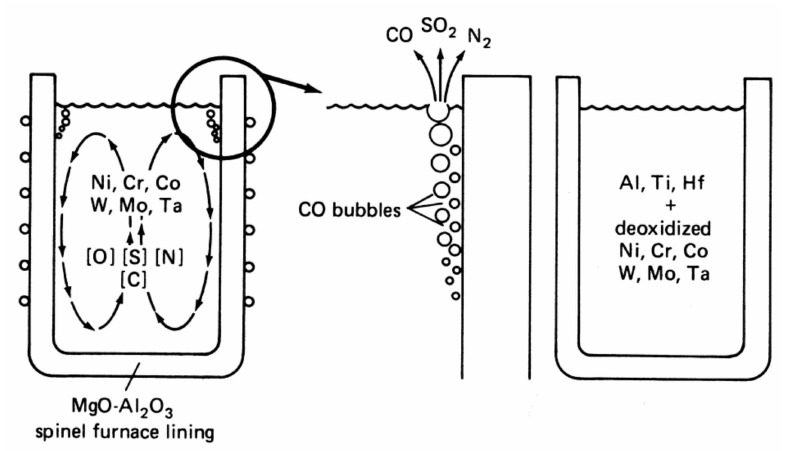
Figure 3. Scheme of vacuum induction refining process. Reproduced with permission [61]. Copyright 2008 ASM International.